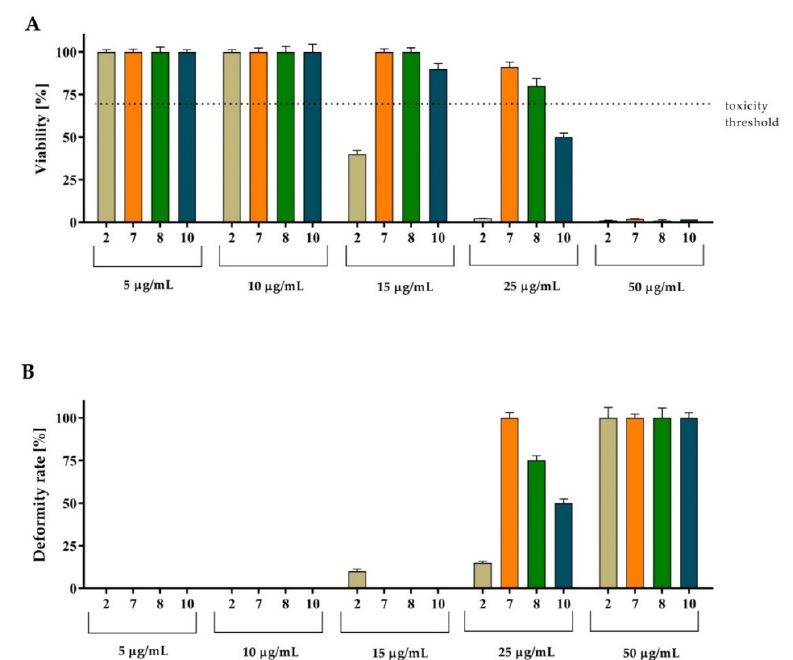
Figure 4. Overview of zebrafish embryo toxicity test after 96 h of exposure to TZD hybrid molecules 2 , 7 , 8 , and 10 (n = 30). ( A ) Toxicity of 2 , 7 , 8 , and 10 measured by the FET test at 96 hpf. ( B ) Impact of tested compounds on zebrafish development. Statistical significance was calculated using ANOVA analysis, followed by Dunnett’s post hoc test (vs negative control group). Concentrations above 50 µg/mL resulted in 100% mortality and deformity.